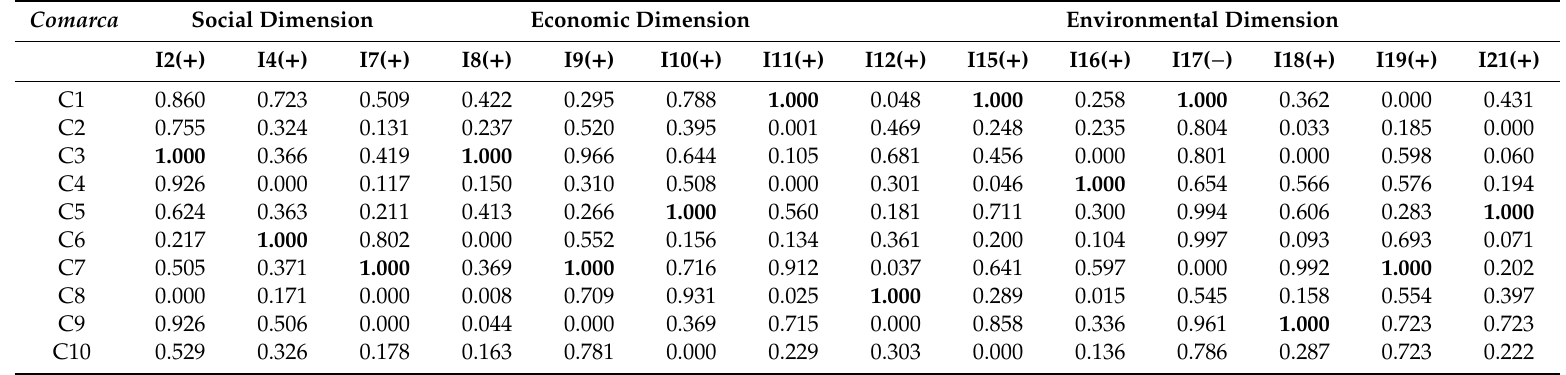
Table 2. Final indicators by comarca and dimension. Sign within parentheses indicates type of indicator: ( + ) when having a positive impact and ( − ) when having a negative impact on development. Maximum values are in